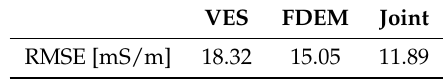
Table 1. Comparison of root-mean-square errors (RMSEs) between the synthetic true model and the three best fit models (ensemble means) for separate and joint inversion of VES and FDEM